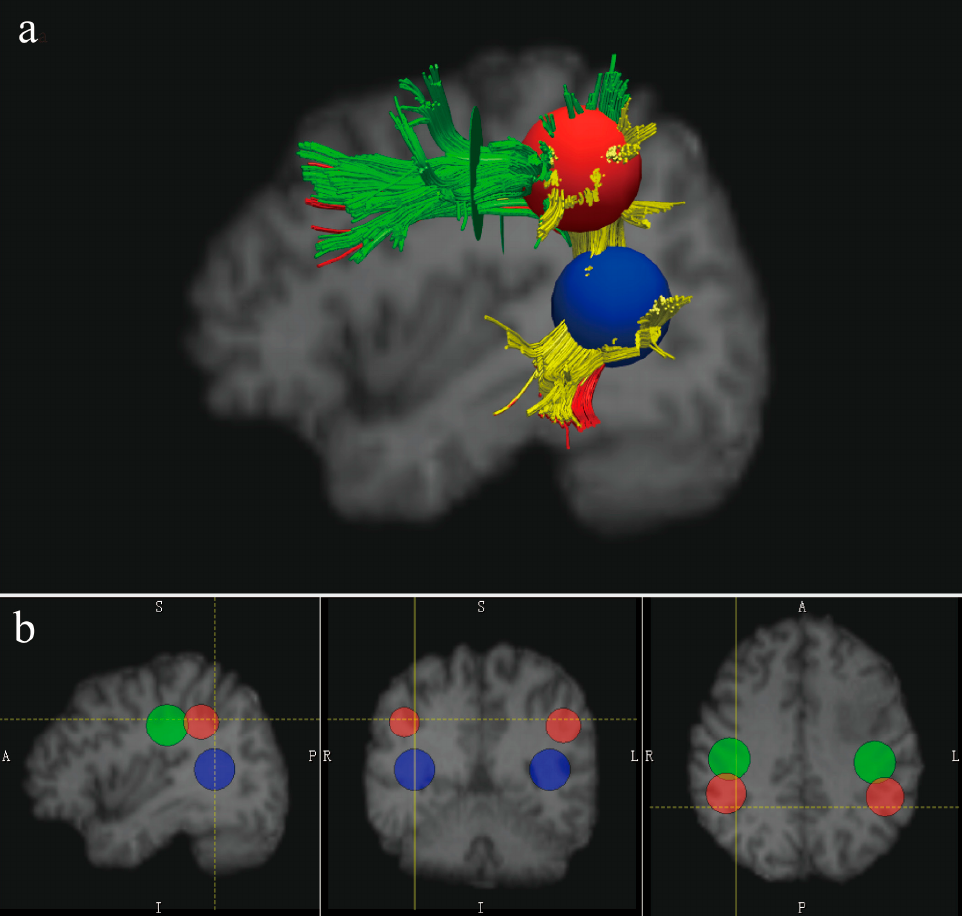
Figure 1. The reconstruction of the bilateral arcuate fasciculus (AF). ( a ) A sample of the recon- structed left AF according to the 3-ROIs approach: AF anterior—green, AF posterior—yellow, and AF long—red; and ( b ) the location of the three ROIs on the normalized T1 images (ROI 1—the green 2D disk, ROI 2—the red 3D sphere, and ROI 3—the blue 3D sphere).